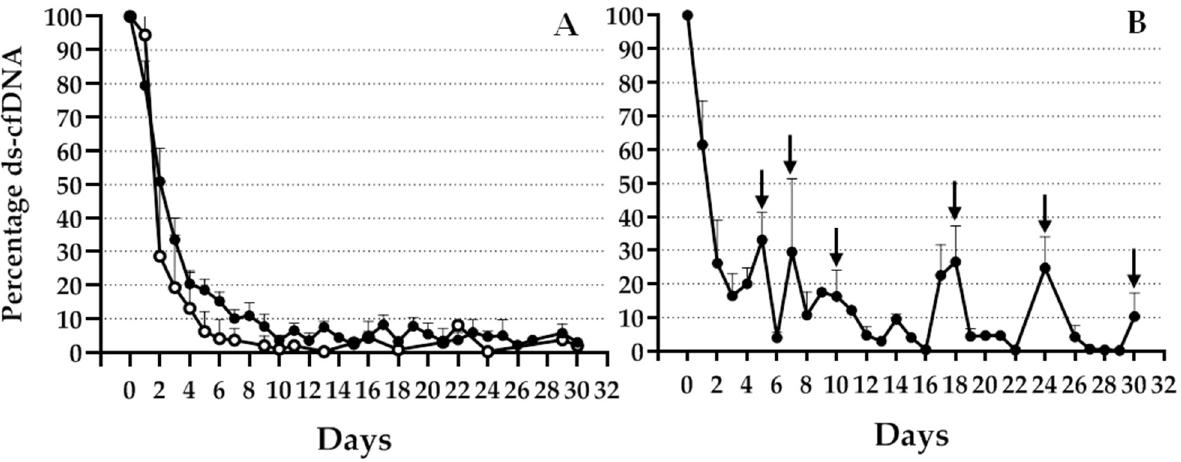
Figure 2. Percentage decrease in ds-cfDNA during the first month post TX. Percentage decrease in ds-cfDNA levels (KEG/mL) from day 0 of TX. ( A ) Patients who accepted transplanted livers without any complications and rejection (black circles) or rejection during a 2-year period (white circles). ( B ) Patients with BPR during the first month after TX. Data expressed as mean + SEM.